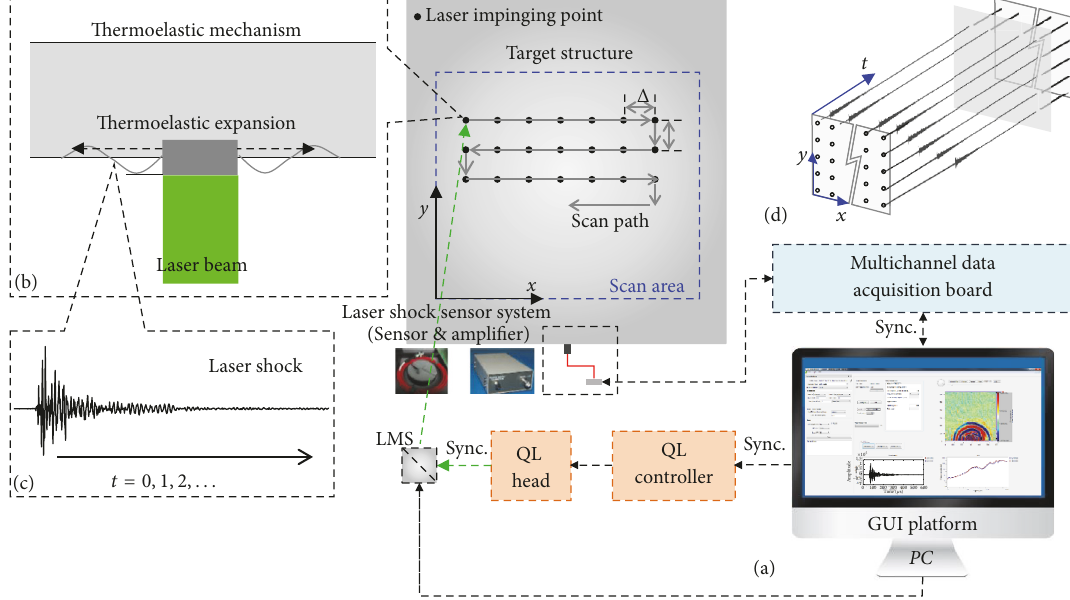
Figure 3: Laser shock measurement process scheme; (a) PC with GUI platform. (b) Thermoelastic mechanism. (c) Laser shock time domain signal. (d) Laser scanning